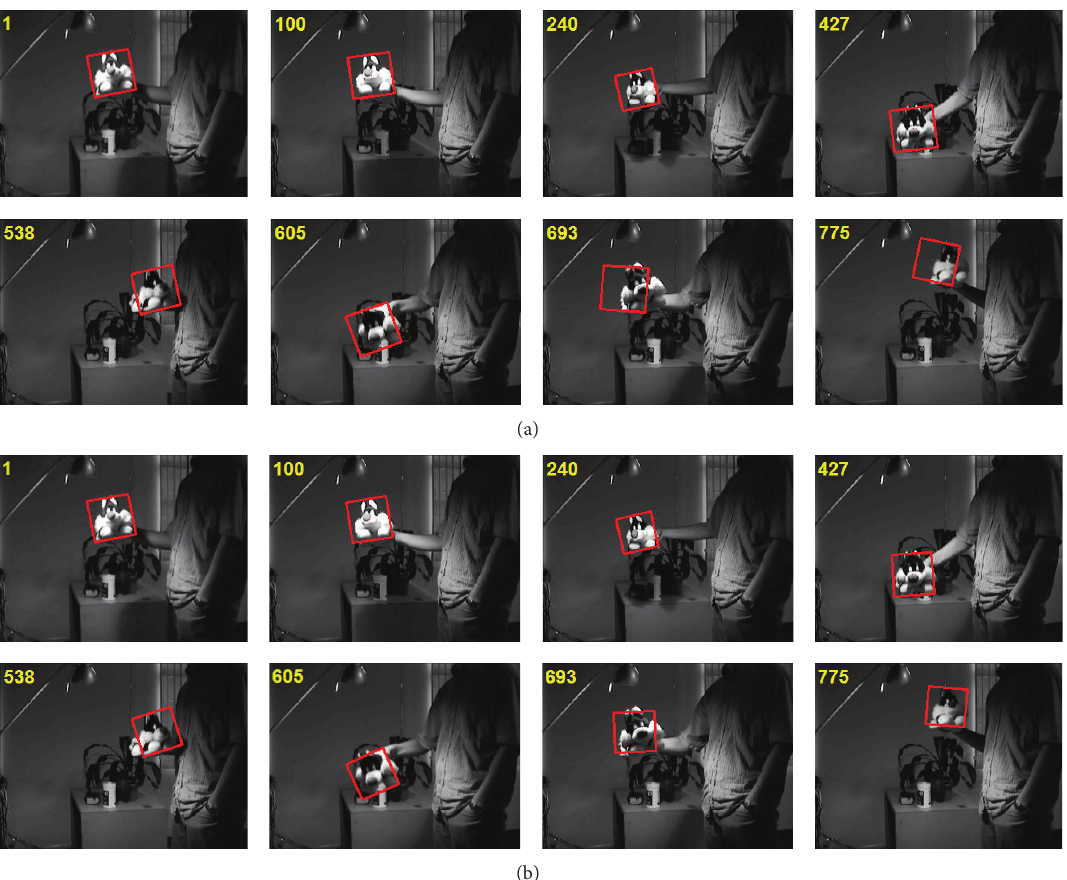
Figure 9: Tracking results for seq.3. The first two rows: results for IVT. The last two rows: results for our method.